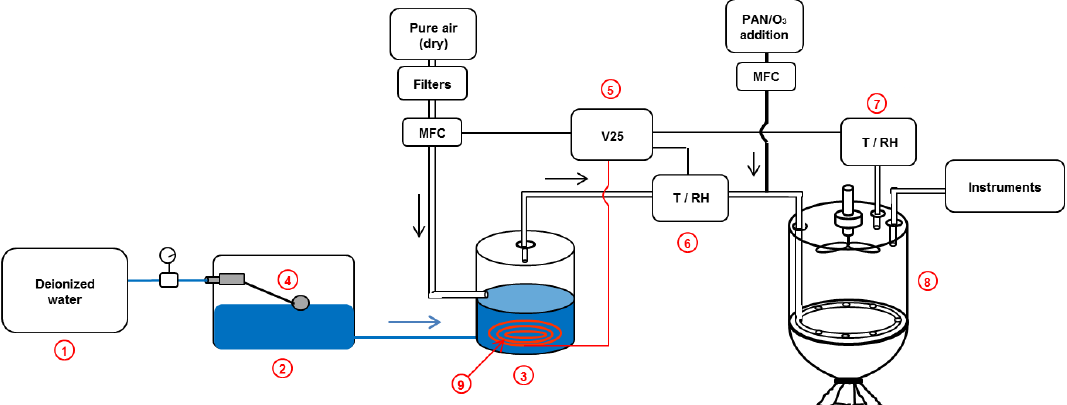
Figure 3. Flow chart of the automatic temperature regulated air humidification system (ATRAHS). 1 – deionized water supply; 2 – water storage tank; 3 – humidifier tank; 4 – float valve; 5 – V25 control device; 6 – T/RH sensor (initial regulation); 7 – T/RH sensor (monitoring); 8 – dynamic cuvette; 9 – heat element.